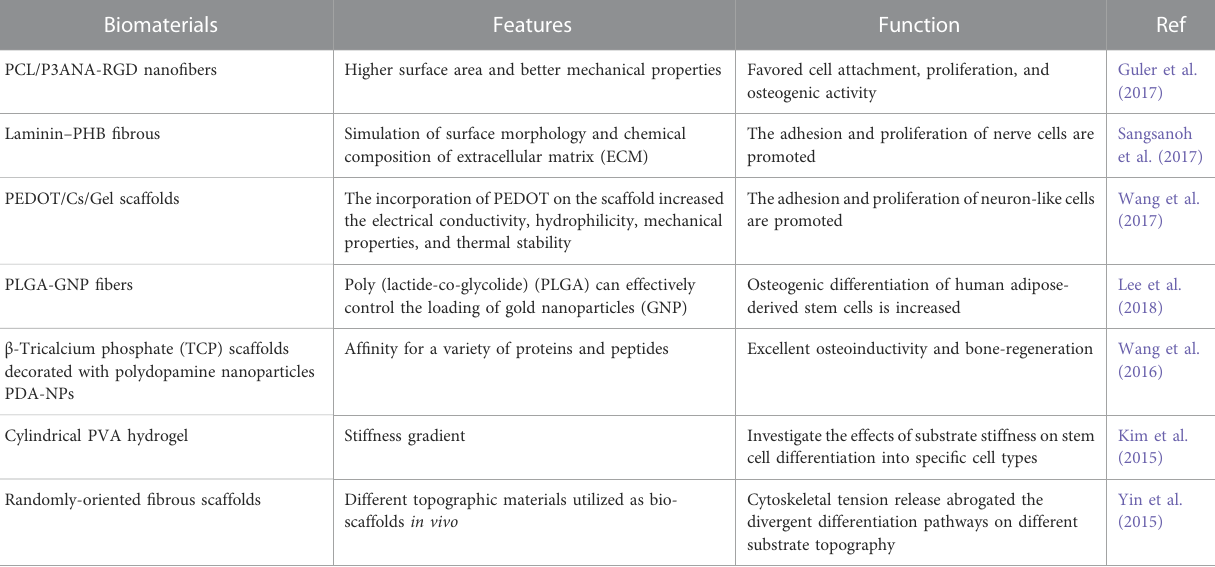
TABLE 1 The effects of material properties on cell behavior.